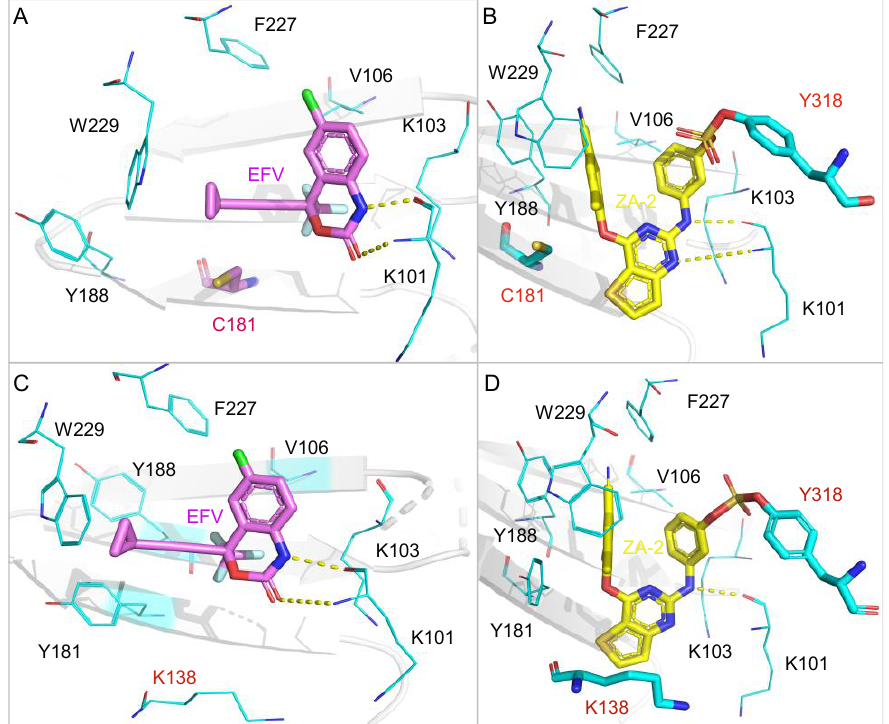
Figure 5. ( A ) The crystal structure of EFV and Y181C HIV-1 RT and ( B ) predicted binding modes of ZA-2 with Y181C HIV-1 RT (PDB code: 1JKH), ( C ) EFV with E138K HIV-1 RT and ( D ) ZA-2 with E138K HIV-1 RT (PDB code: 6C0P) [19,21]. All hydrogen bonds are shown as yellow dotted lines. Nonpolar hydrogen atoms are not shown for